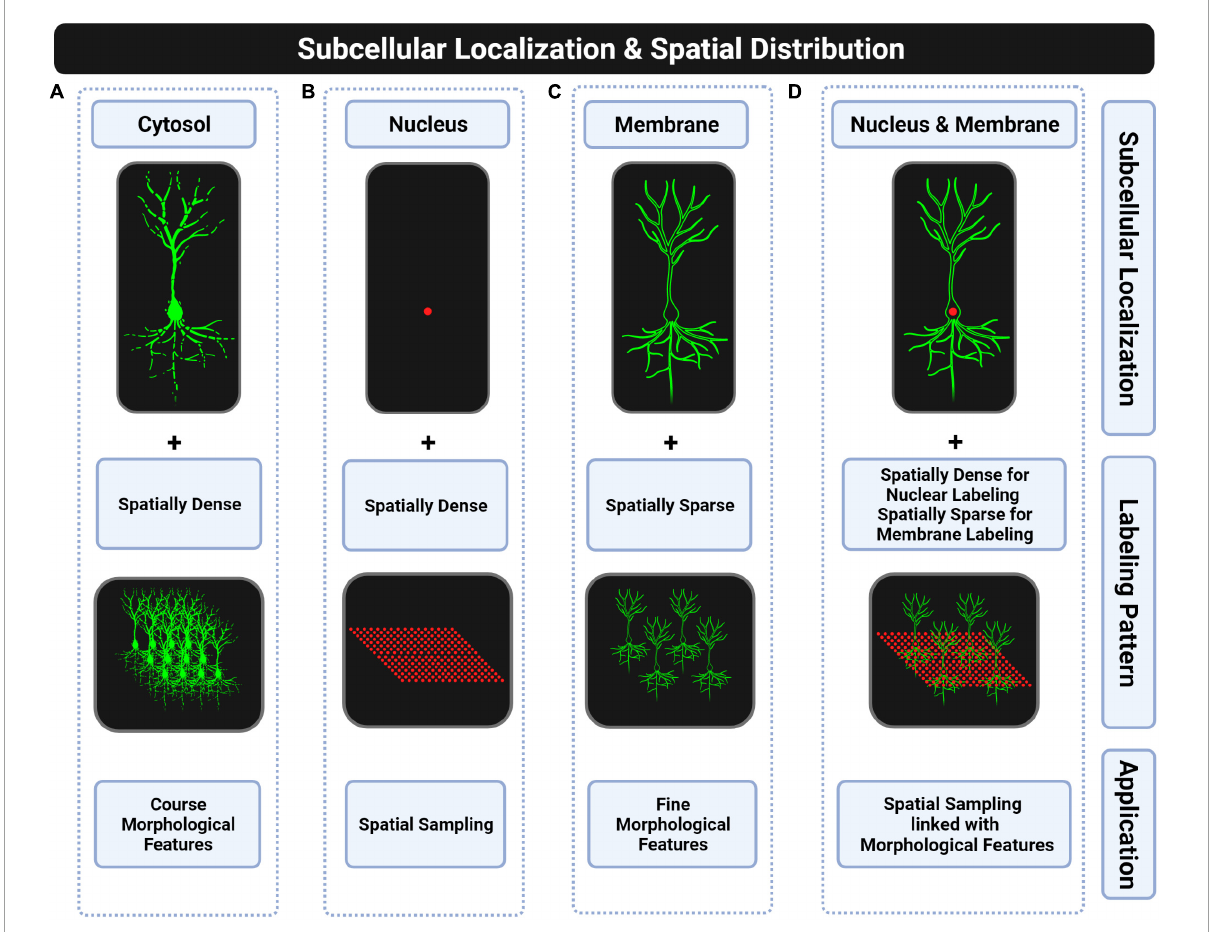
FIGURE4 Subcellular locations of fluorescent proteins for whole-brain applications. (A) Cytosolic targeting with spatially dense labeling is suitable for extracting coarse morphological features such as dendritic or axonal density of a particular cell type. Discontinuities of the fluorescent signal in distal thin processes and too dense labeling make this approach unsuitable for morphological reconstructions. (B) Nuclear targeting with spatially dense labeling is suitable for counting complete cell-type populations. (C) Plasma membrane targeting with spatially sparse labeling is suitable for full morphological reconstructions. (D) Combining the two previous strategies is suitable for linking soma spatial distribution with morphological features of single neurons. However, this strategy has not been fully explored due to the lack of transgenic mice that combine both